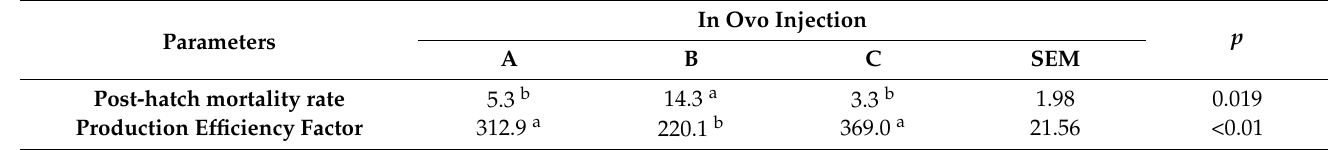
Table 3. The effects of in ovo injection of vitamin C on post-hatch mortality and production efficiency factor